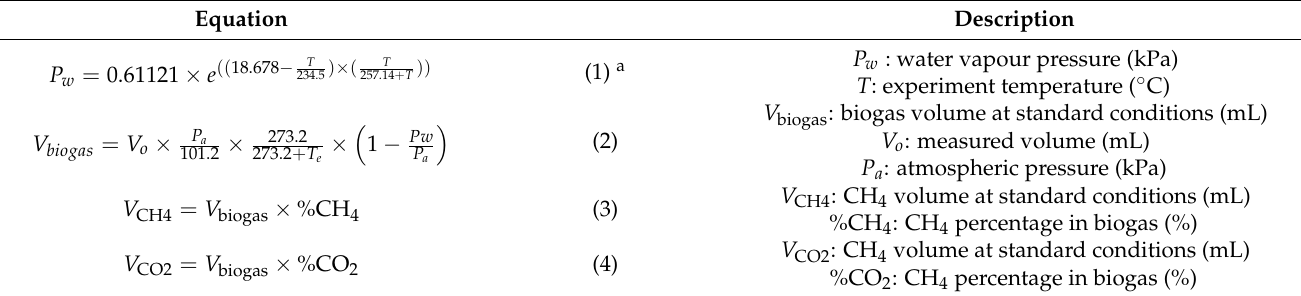
Table 2. Calculation of biogas and methane produced in